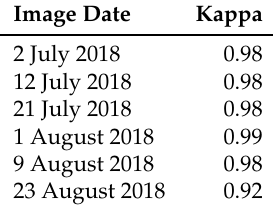
Table 8. Classifier accuracy for a time series of images over the untreated (U) untreated channel.